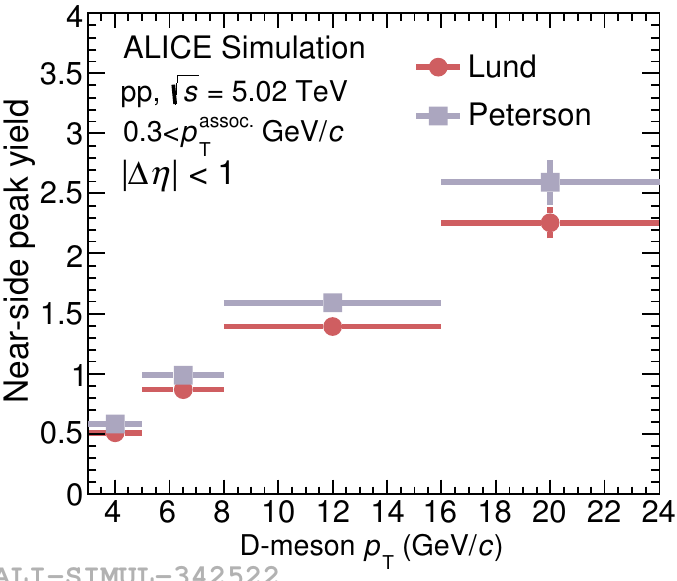
Figure 3. Near-side peak yield of simulated D–h correlations with different heavy-flavour fragmen- tation models in pp collision at GeV/ c